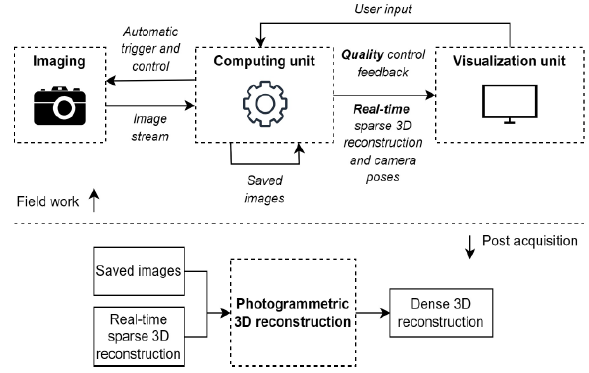
Figure 2 . High level architecture and workflow of GuPho’s concept.